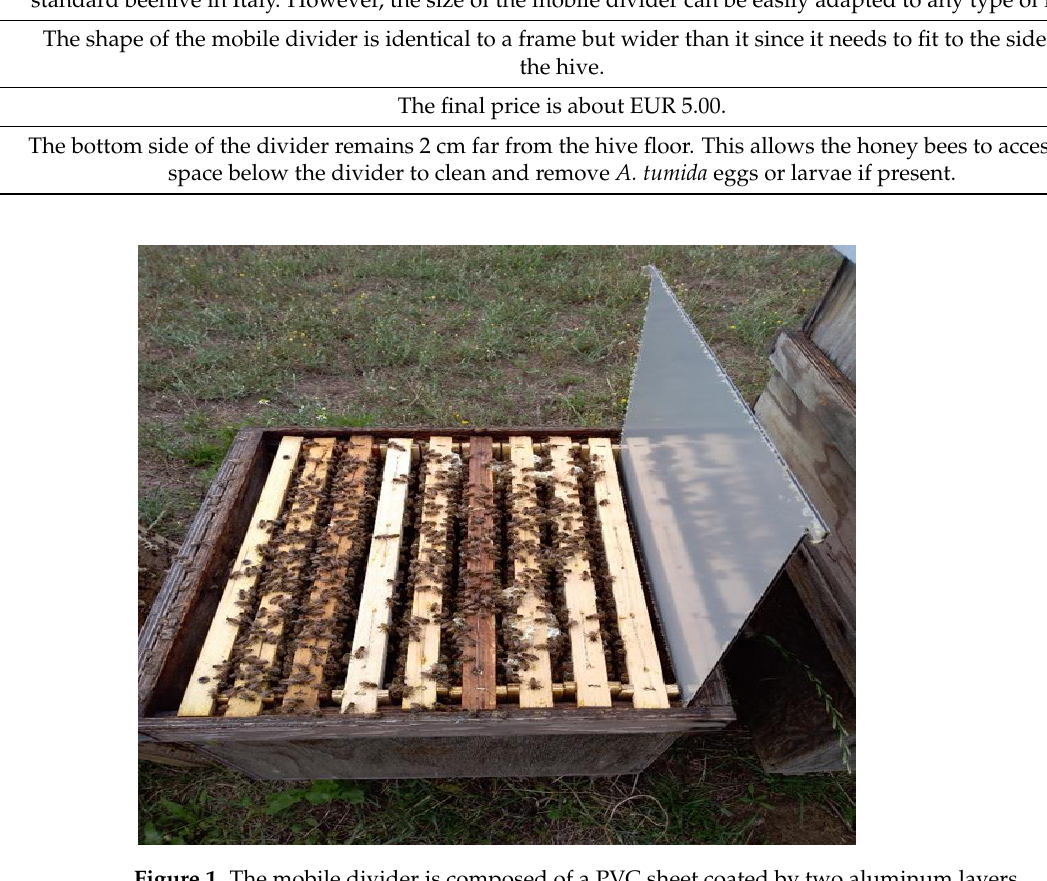
Figure 1. The mobile divider is composed of a PVC sheet coated by two aluminum layers.